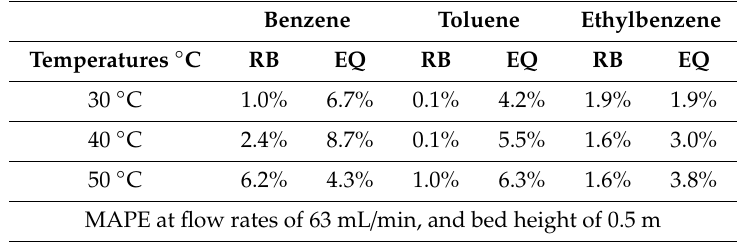
Table 6. MAPE between the values calculated using the models (rate-based (RB) and equilibrium-stage (EQ)) and those obtained from empirical measurement at a bed height of 0.5 m.